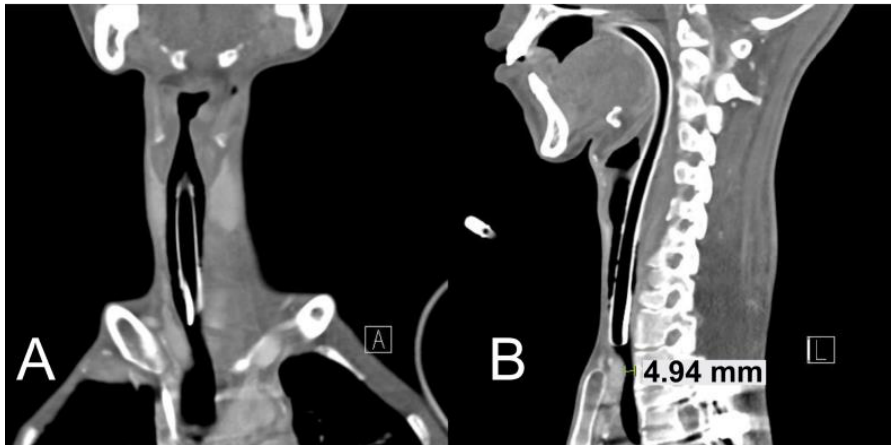
Figure 1. Neck computed tomography images before tracheostomy. ( A ) The coronal view shows that the tip of endotracheal tube and innominate artery are adjacent. ( B ) The sagittal view shows the innominate artery pressing the trachea.